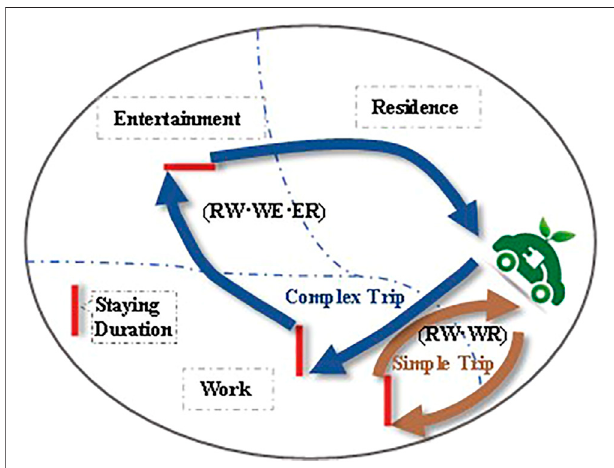
FIGURE 1 | EV traveling trajectory with two types of trip chains.